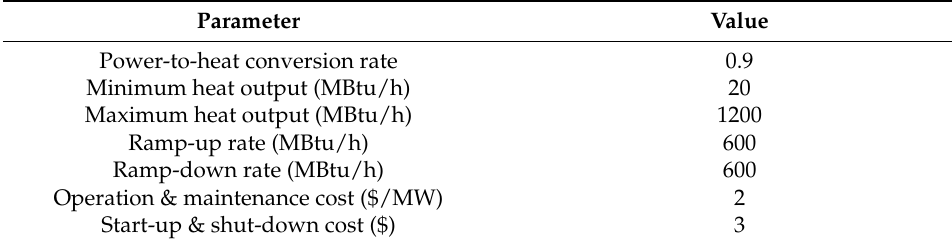
Table A3. Heat pump parameters.